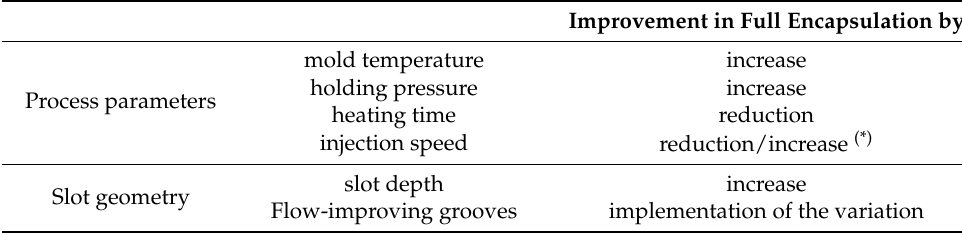
Table 3. Improvement in full encapsulation of the wires within the stack in the insulation system of the single slot sample by process conditions and slot geometry. Improvement in Full Encapsulation by mold temperature increase holding pressure increase Process parameters heating time reduction injection speed reduction/increase (*) slot depth increase Slot geometry Flow-improving grooves implementation of the variation (*) : relative to time and temperature-dependent viscosity route of the